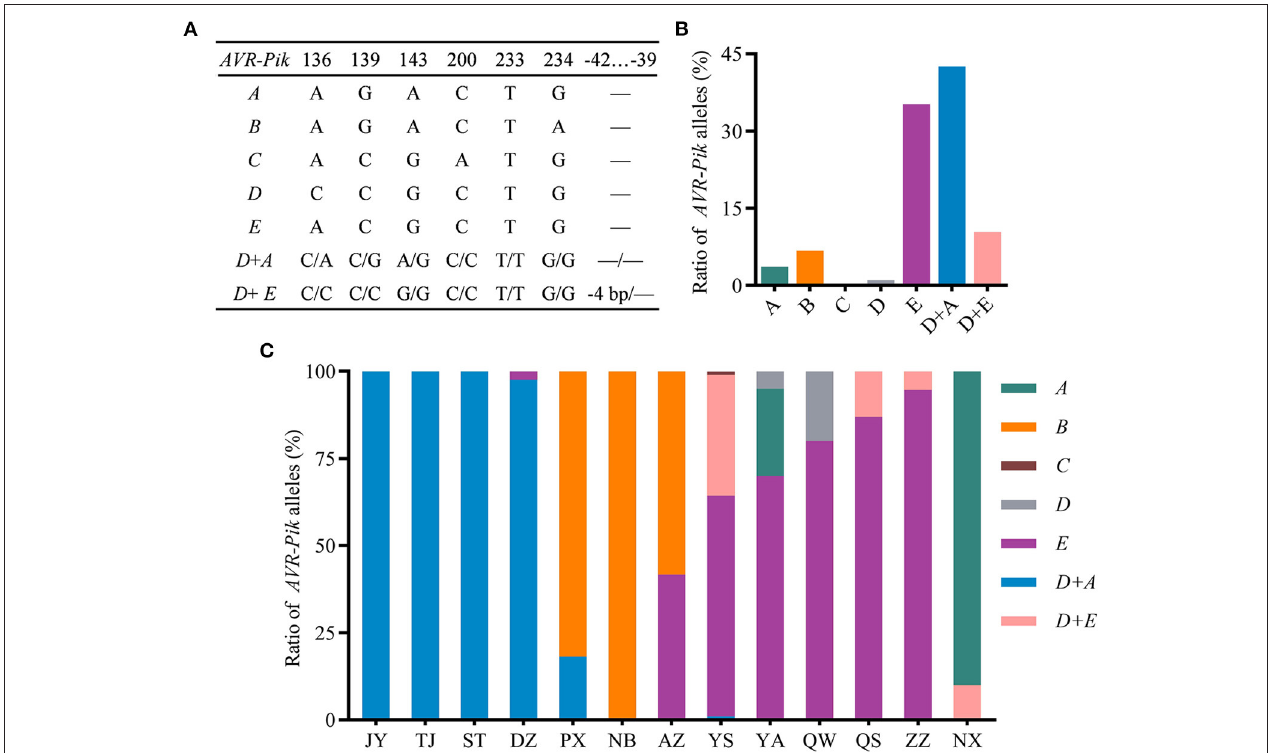
FIGURE 6 | The variation and distribution of AVR-Pik alleles in the Sichuan Basin. (A) AVR-Pik alleles characterized in the isolates from the Sichuan Basin. − 4bp, CTTT is deleted at − 42 to − 39 of the promoter of AVR-PikD . —, no change compared with WT. (B) Ratio of isolates harboring different AVR-Pik alleles. (C) Ratio of AVR-Pik alleles in the indicated 13 prefectures in the Sichuan